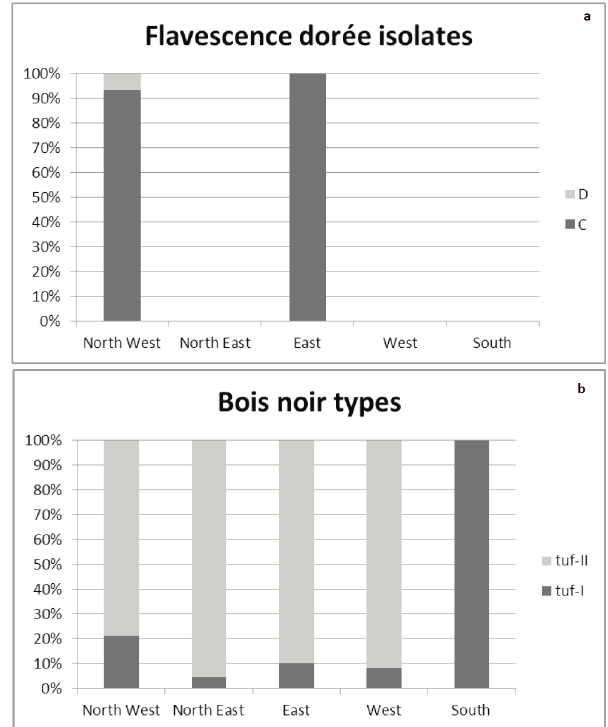
Fig. 5 - Samples positive to “bois noir” in Tuscan areas in 2012-